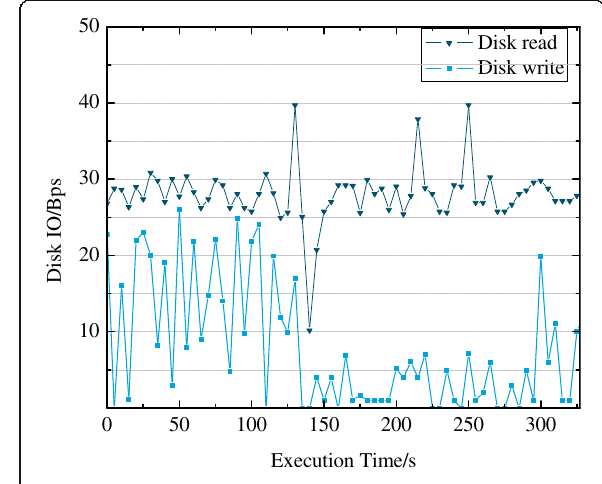
Fig. 7 The disk utilization of